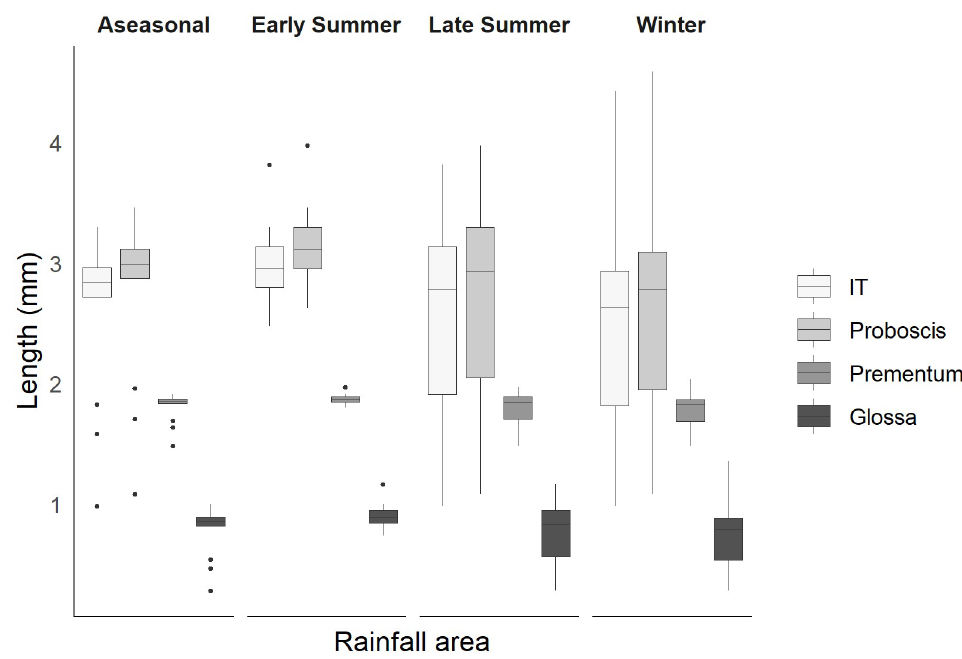
Fig 4. Estimated length of mouthparts (proboscis, prementum and glossa) across rainfall regions. Each panel represents the four rainfall regions: aseasonal, early summer, later summer and winter. Boxplots of measured IT and estimated proboscis, prementum and glossa length for 56 species of Melittidae. Dots represent outliers. Proboscis, prememtum and glossa length was estimated from measured IT using family-specific scaling coefficients.